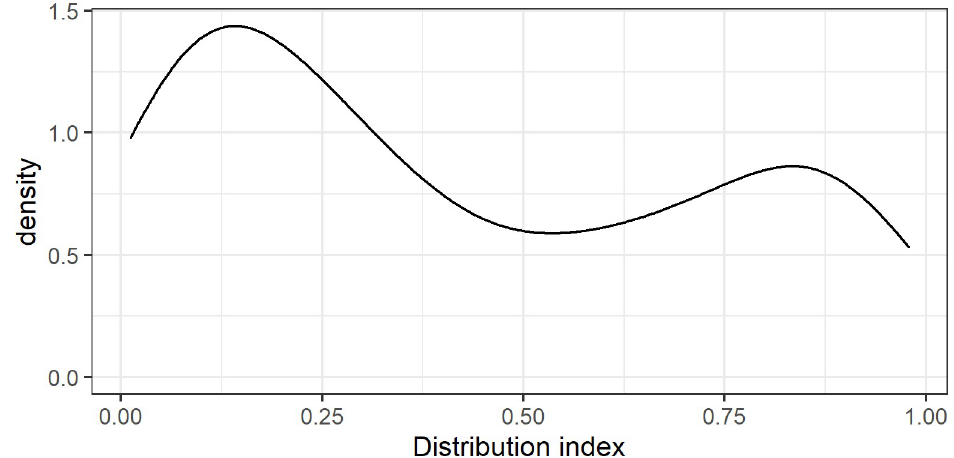
Fig 2. Distribution index of the variants (density). Density of the distribution indices of the indigenous variants in the collected data (mean = .42; standard deviation of the mean = .32).